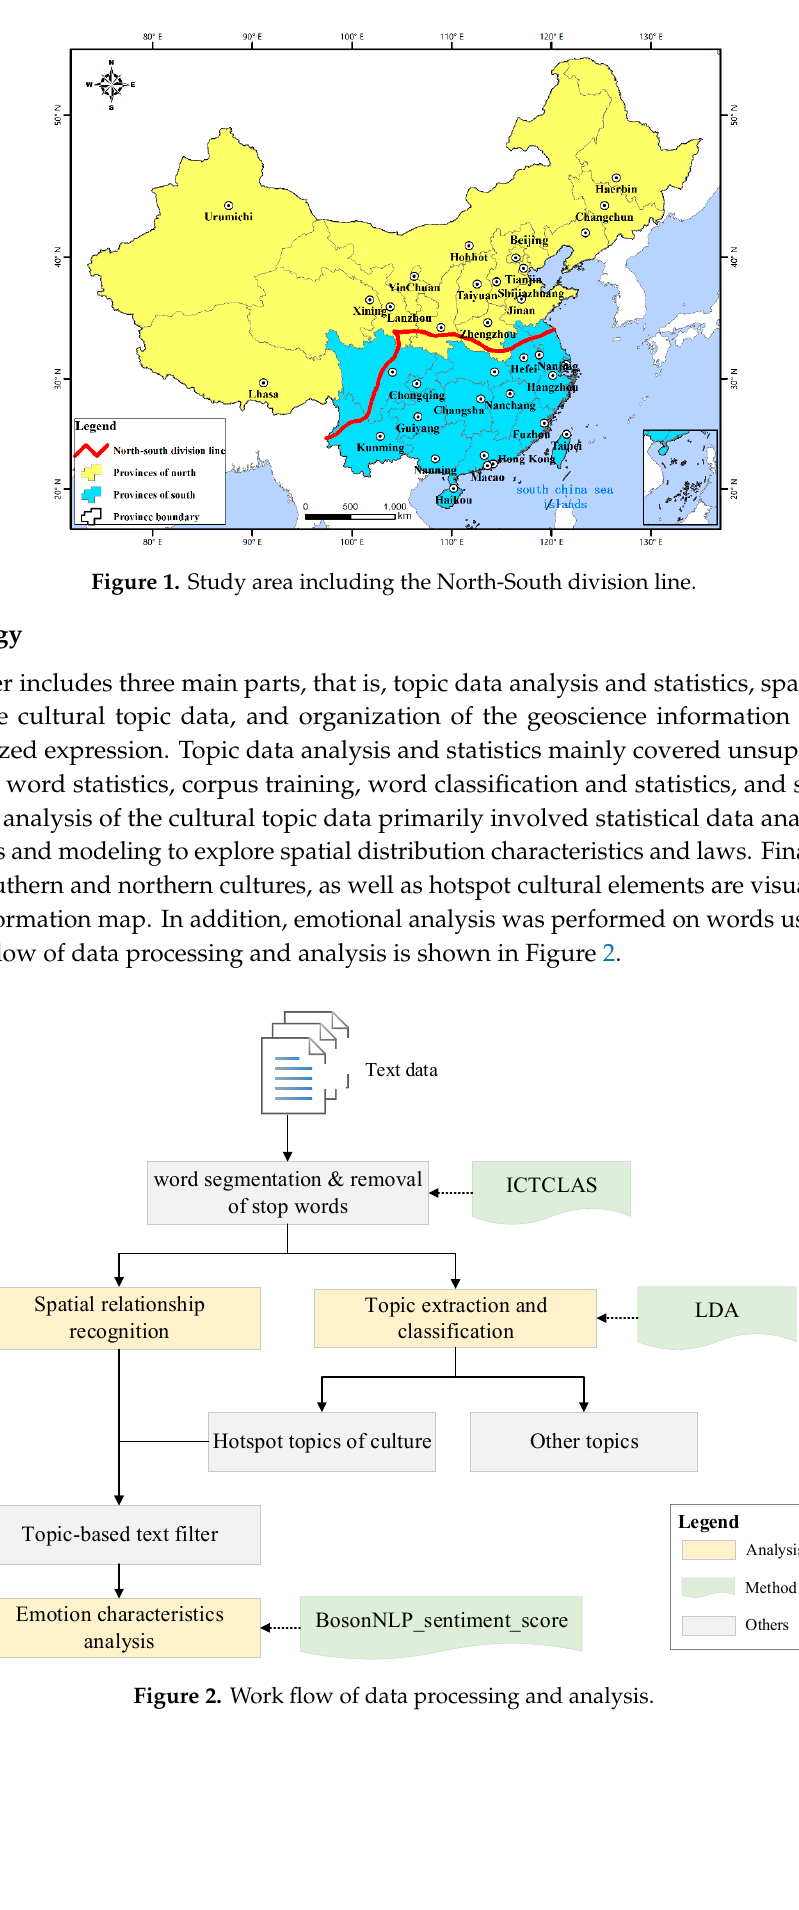
Figure 1. Study area including the North-South division line.